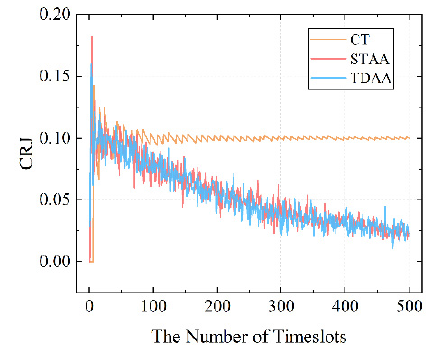
9 of 14 Figure 4. Schematic diagram of the probability distribution of timeslot interference. 4.2. Analysis of Simulation 4.2.1. Basic Analysis of Indicators Through the above-described background settings, the collision rate of jamming and the average reward in each period of continuous transmission of the STAA and the TDAA with a normal distribution of random pulse interference in the time domain were com- pared. Figure 5 shows that the STAA can effectively reduce the probability of interference